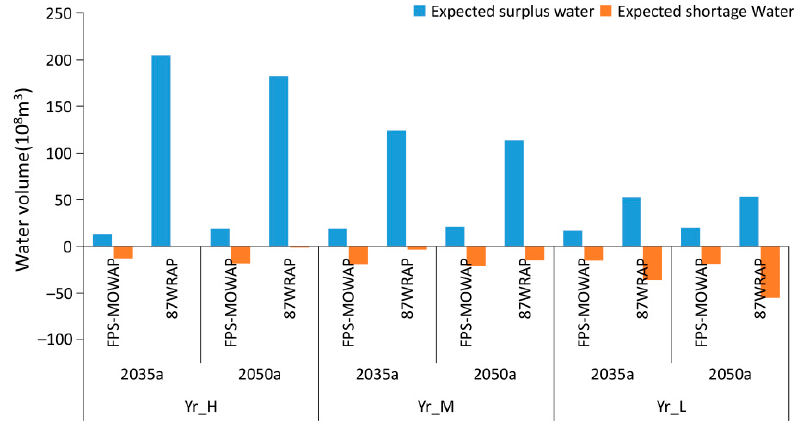
Figure 12. Expected surplus and shortage water under the FPS-MOWAM scheme and 87WRAP in 2035 and 2050 for the Yellow River Basin in wet, normal, and dry years.